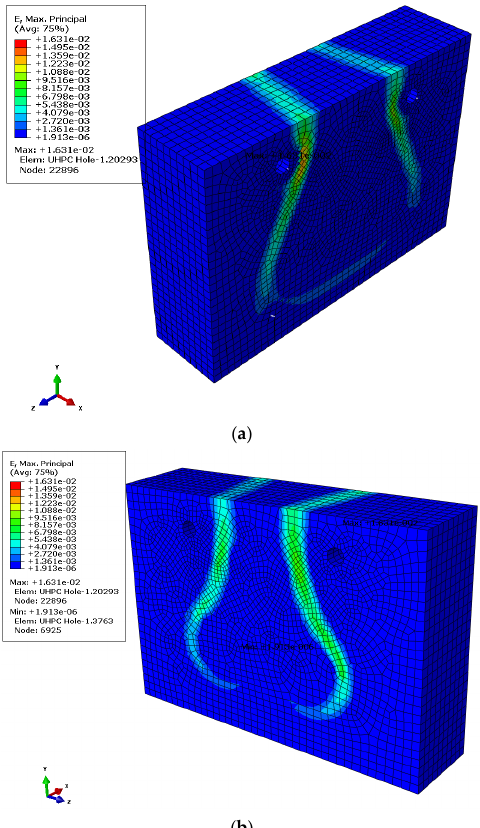
Figure 17. Total strain components, Max, Principal Strain for ( a ) reaction (front) side and ( b ) forcing (rear) side.